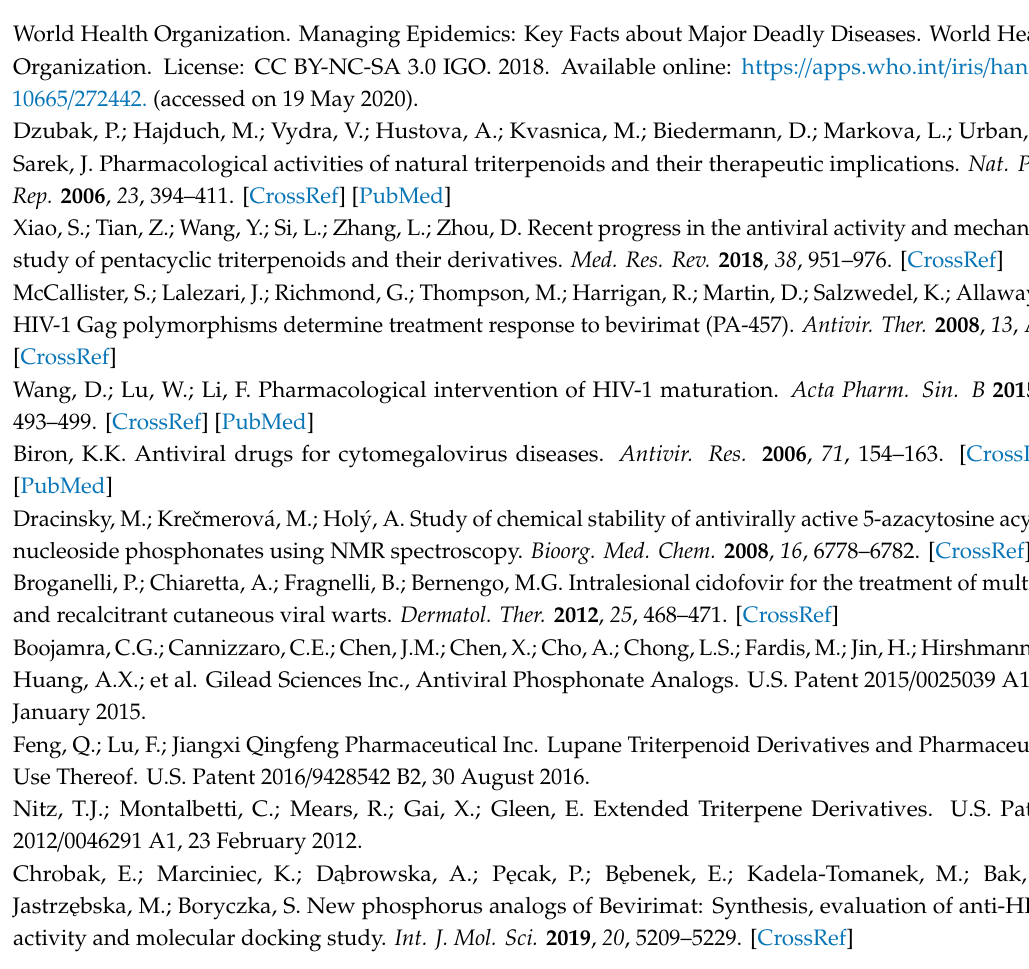
BVM in the tested concentration range, Figure S2: Cytotoxicity of betulin phosphate 2–5 in the tested concentration range, Table S1: Selected physicochemical properties of the compounds 2–5, Table S2: Scoring functions of the tested compounds (SARS-Cov-2 proteins), Figure S3: The lowest-energy docking poses of SARS-Cov-2 Mpro protein complexes with BVM (A) and betulinic acid (B), Figure S4: Visualization of interaction between BVM (A) and compound 4 (B) with SARS-Cov-2 RdRp, Figure S5: Docking pose of SARS-Cov-2 E protein complexes with BVM (A) and compound 6 (B), Figure S6: Visualization of interaction between betulinic acid (A) and BVM (B) with SARS-Cov-2 spike protein monomer, Figure S7: RMSD for atoms of protein (Mpro, RdRp, E) backbones (left) and ligands (right), Figure S8: RMSD for atoms of S protein backbones (left) and ligands (right), Figure S9: RMSD for atoms of E protein backbones without terminal residues, Table S3: Interactions of tested compounds with SARS-CoV-2 proteins (References [59,60] are cited in the supplementary